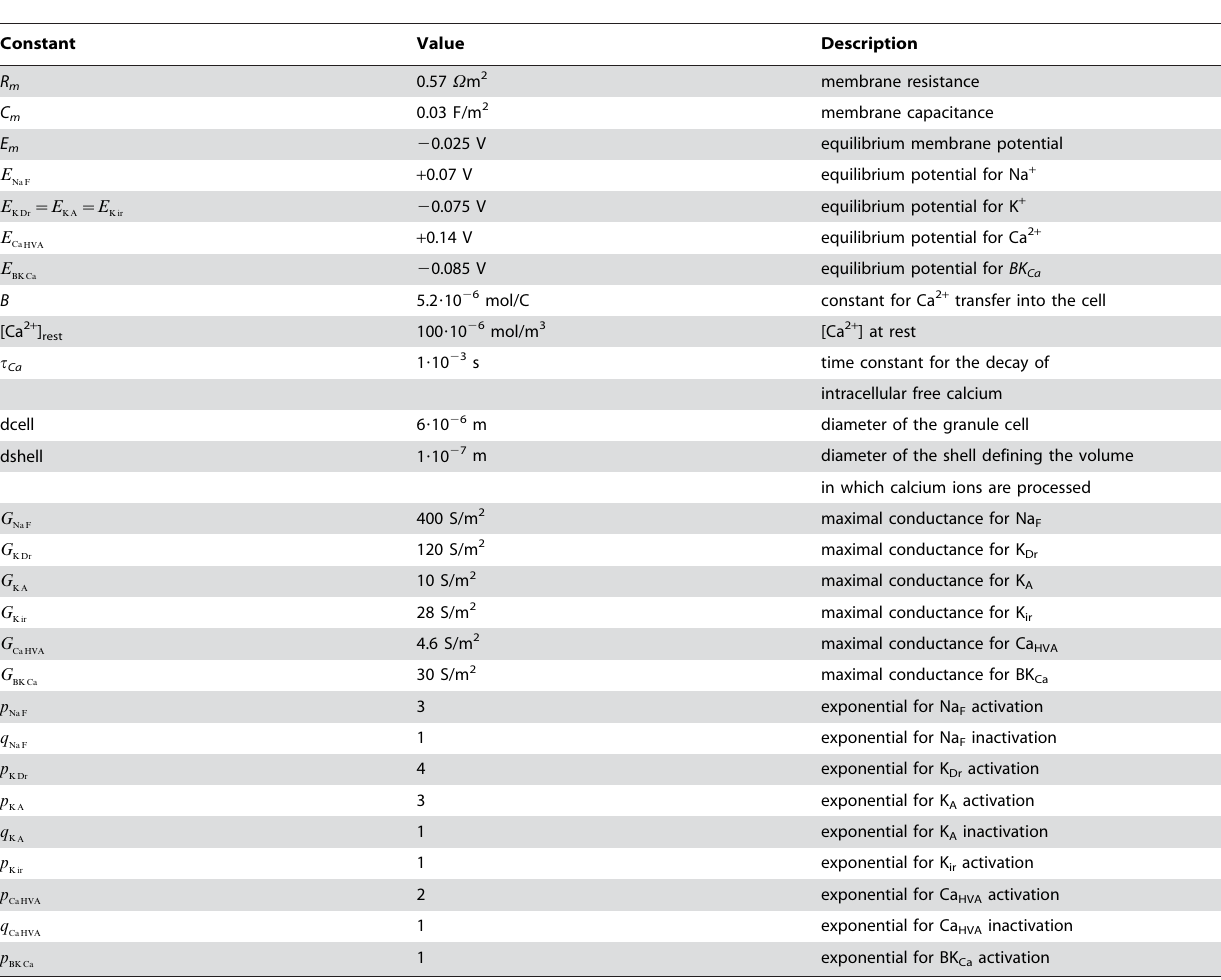
Table 1. Parameter values used in both stochastic and deterministic